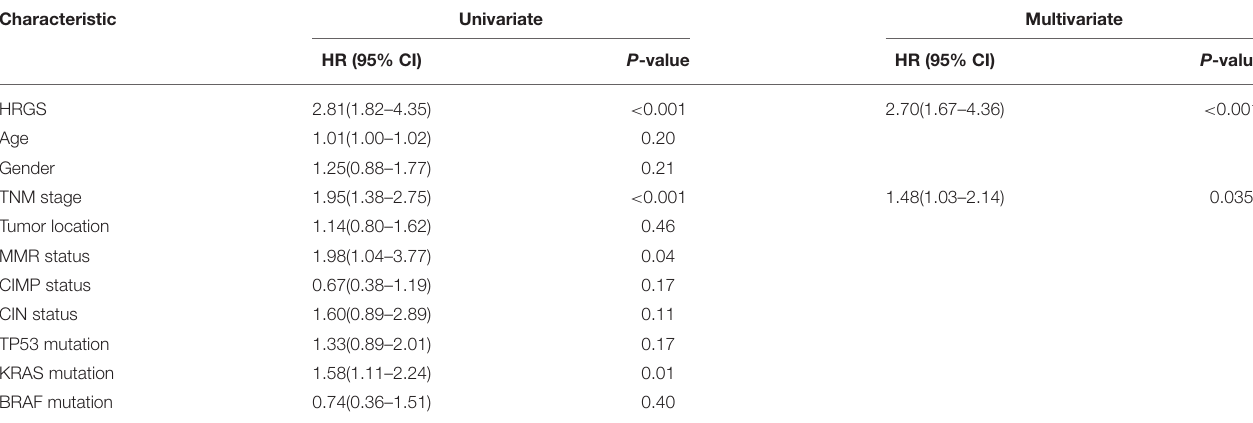
TABLE 2 | Univariate and multivariate analyses of HRGS and clinical and pathologic factors with DFS of stage II/III patients in training cohorts (CIT/GSE39582). Characteristic Univariate